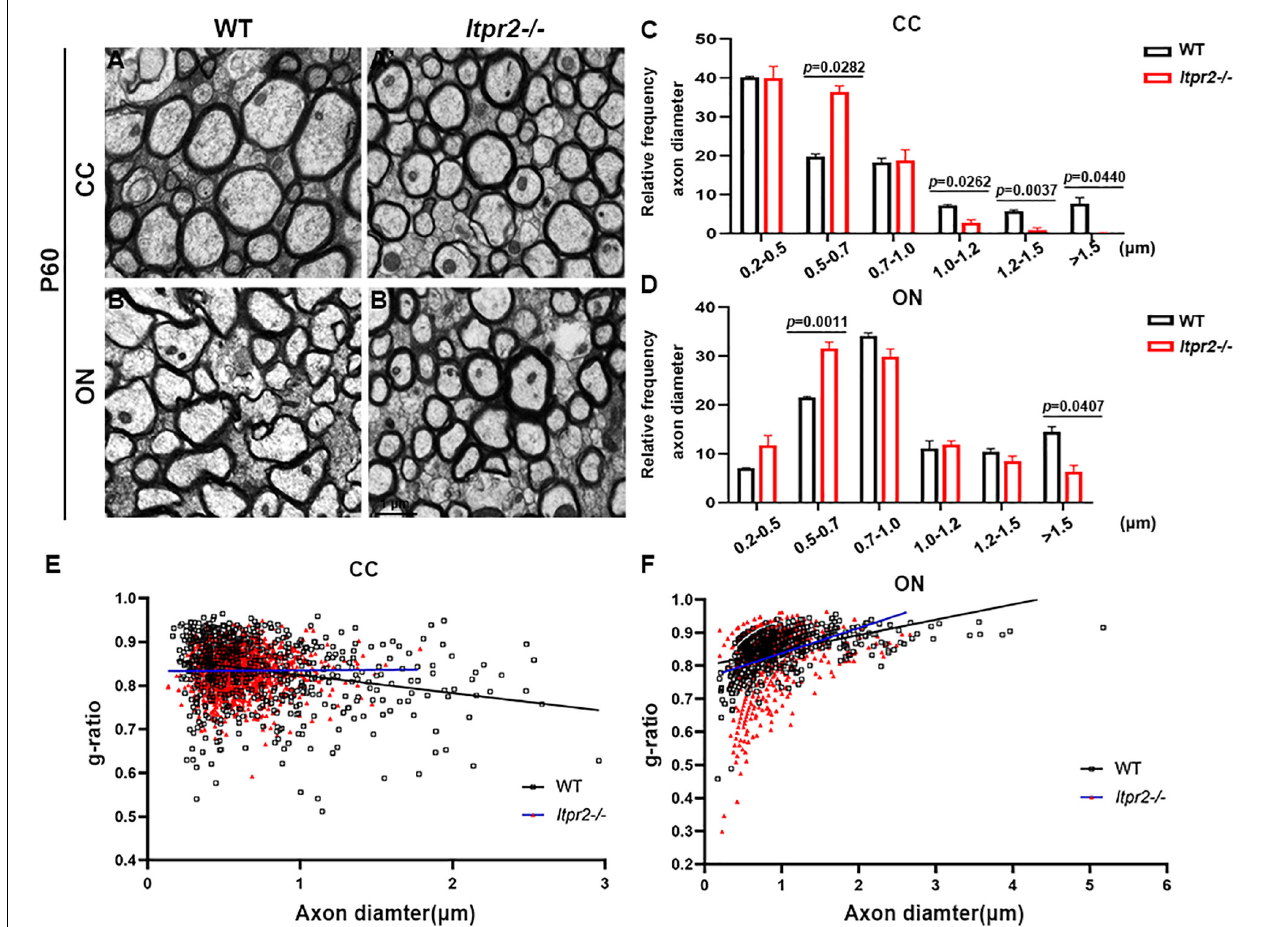
FIGURE 3 | Knockout Itpr2 increases the percentage of small-diameter myelinated axons in corpus callosum and optic nerve. (A–B (cid:48) ) Electron microscopy images of the corpus callosum (CC) (A,A (cid:48) ) and optic nerve (ON) (B,B (cid:48) ) from P60 wild-type and Itpr2 − / − mice. Scale bar represents 1 µ m. (C) Quantification of percentage of myelinated axons in the corpus callosum by size. An increased number of myelinated small-diameter axons ( < 0.7 µ m) and a decreased number of myelinated large-diameter axons ( > 1.5 µ m) were observed in Itpr2 mutants. Two-way ANOVA P -values summary: interaction: F = 4.720, p = 0.0036; axon diameter: F = 36.29, p = 0.0010; genotype: F = 0.7167, p = 0.4359. (D) The distribution of axonal size in optic nerve is similar to that in the corpus callosum. Two-way ANOVA P -values summary: interaction: F = 11.61, p < 0.0001; axon diameter: F = 111.1, p < 0.0001; genotype: F = 0.5946, p = 0.4837. (E) The relationship between diameters and g-ratios of axons from the corpus callosum of wild-type and Itpr2KO mice at P60. Averaged g-ratios were 0.836 ± 0.007 (wild-type, 654 axons from 3 animals, black squares) and 0.833 ± 0.008 ( Itpr2 − / − , 1,447 axons from 4 animals, red triangles), p = 0.72. (F) The relationship between